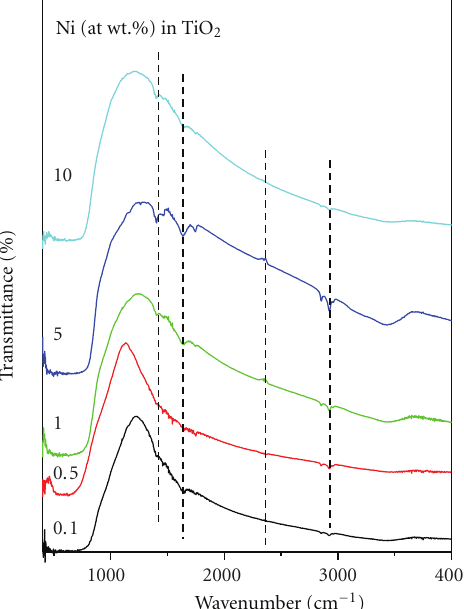
Figure 5: FT-IR spectra of Ni-doped TiO 2 (Ni = 0, 0.1, 0.5, 1, 5, and 10 at. wt.%) powders formed at 550 ◦ C for